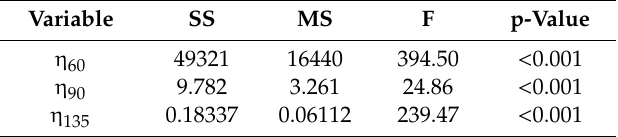
Table 7. Evaluation of the significant influence of the SAA factor on η 60 , η 90 , η 135 (ANOVA). Variable SS